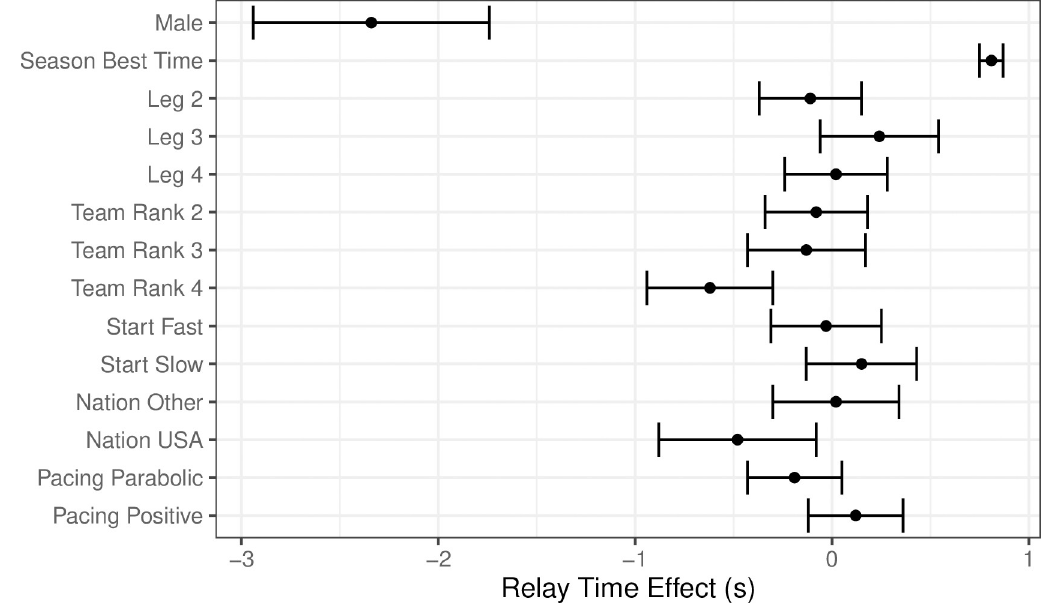
Fig 1. Coefficients for explanatory variables and individual swim performance in the relay. Note that the baseline categorical variable for gender is female, for relay leg is the first leg, team ranking is rank one, pacing start lap strategy is average, nation is Australia, and pacing strategy is even. If the confidence interval does not overlap with 0 , then the effect is considered significant .